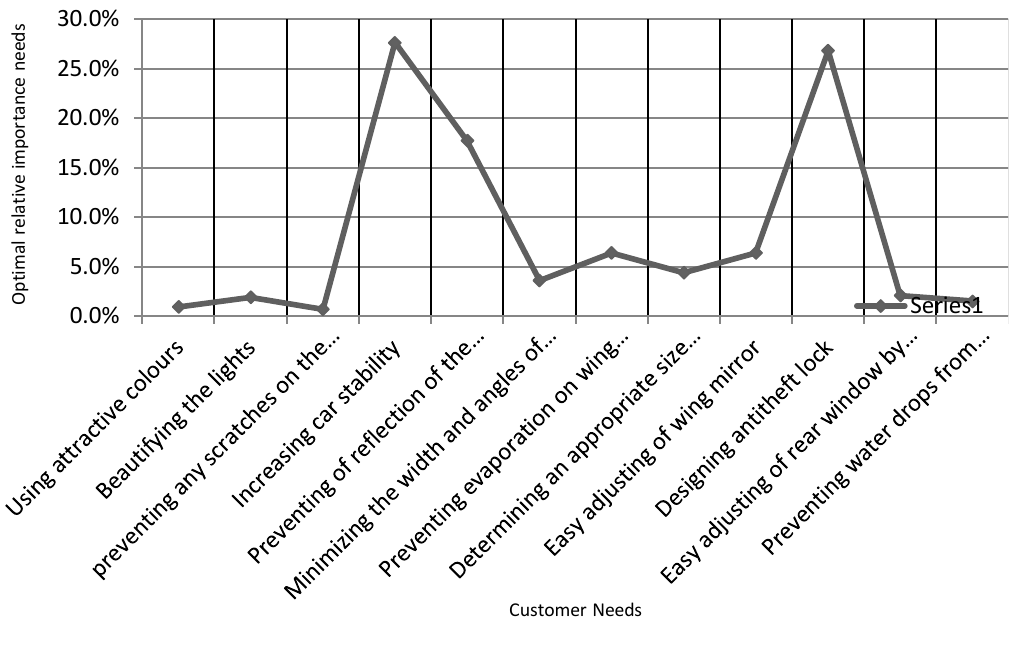
Figure 9. Importance of the customer